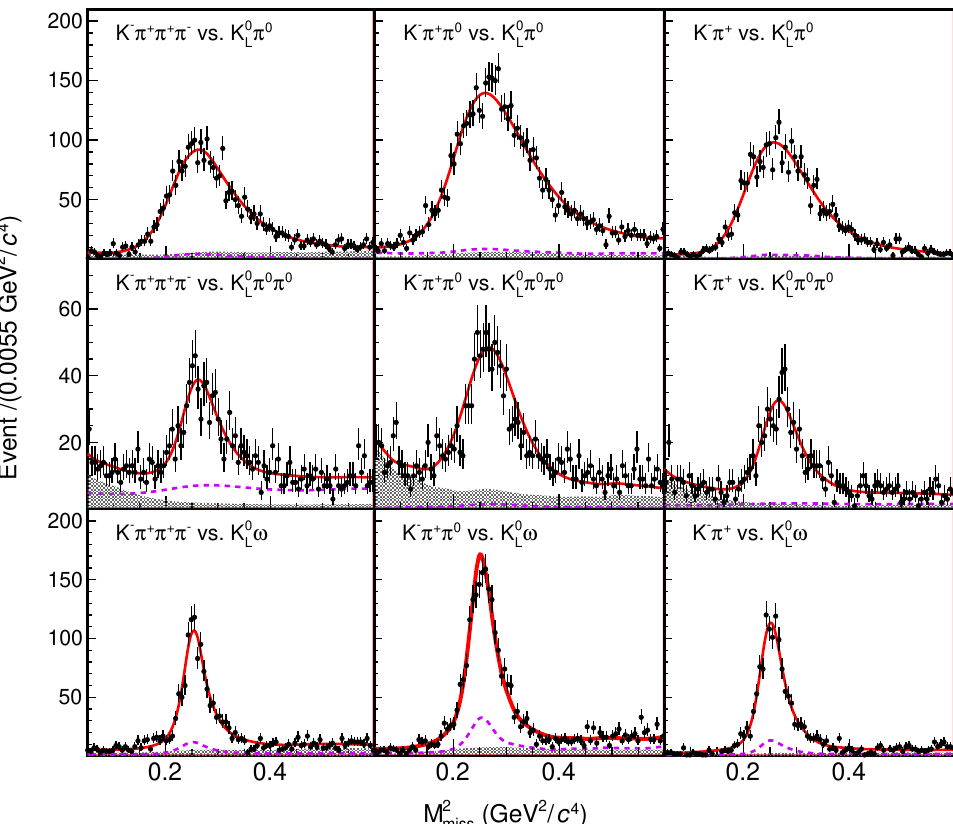
distributions for double tags containing a K 0 Figure 4 . M 2 miss are data; the red line indicates the total fit; the dashed purple line shows the peaking-background contribution; the shaded region represents the combinatorial